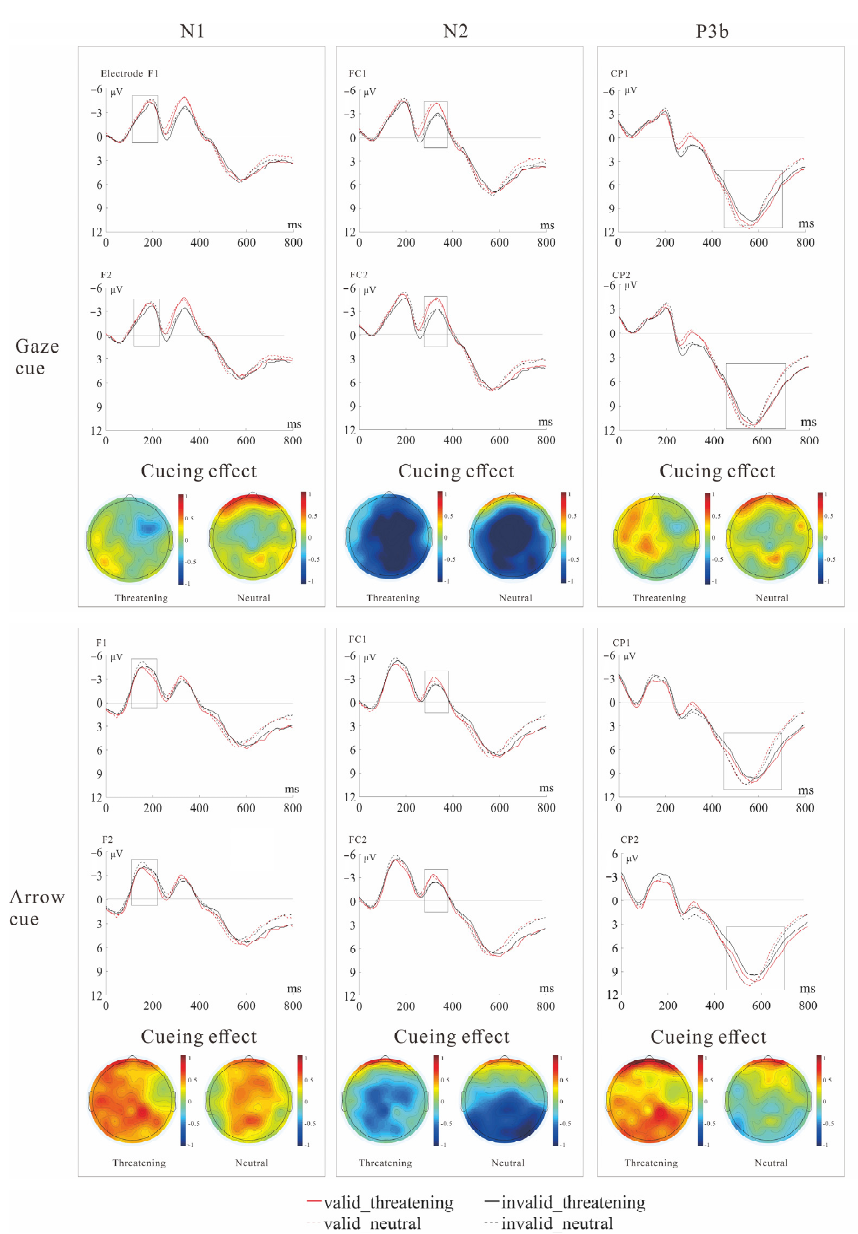
Figure 5. Grand-average target-synchronized ERP waveforms at selected electrodes for each experi- mental condition. Highlighted are the N1 (electrodes F1, F2, left), N2 (electrodes FC1, FC2, middle), and P3b (electrodes CP1, CP2, right) components. Time zero on the x -axis corresponds to target stimulus onset. The topographies beneath the waveforms show the gaze or arrow cue validity effect (valid–invalid) to threatening and neutral targets, respectively.